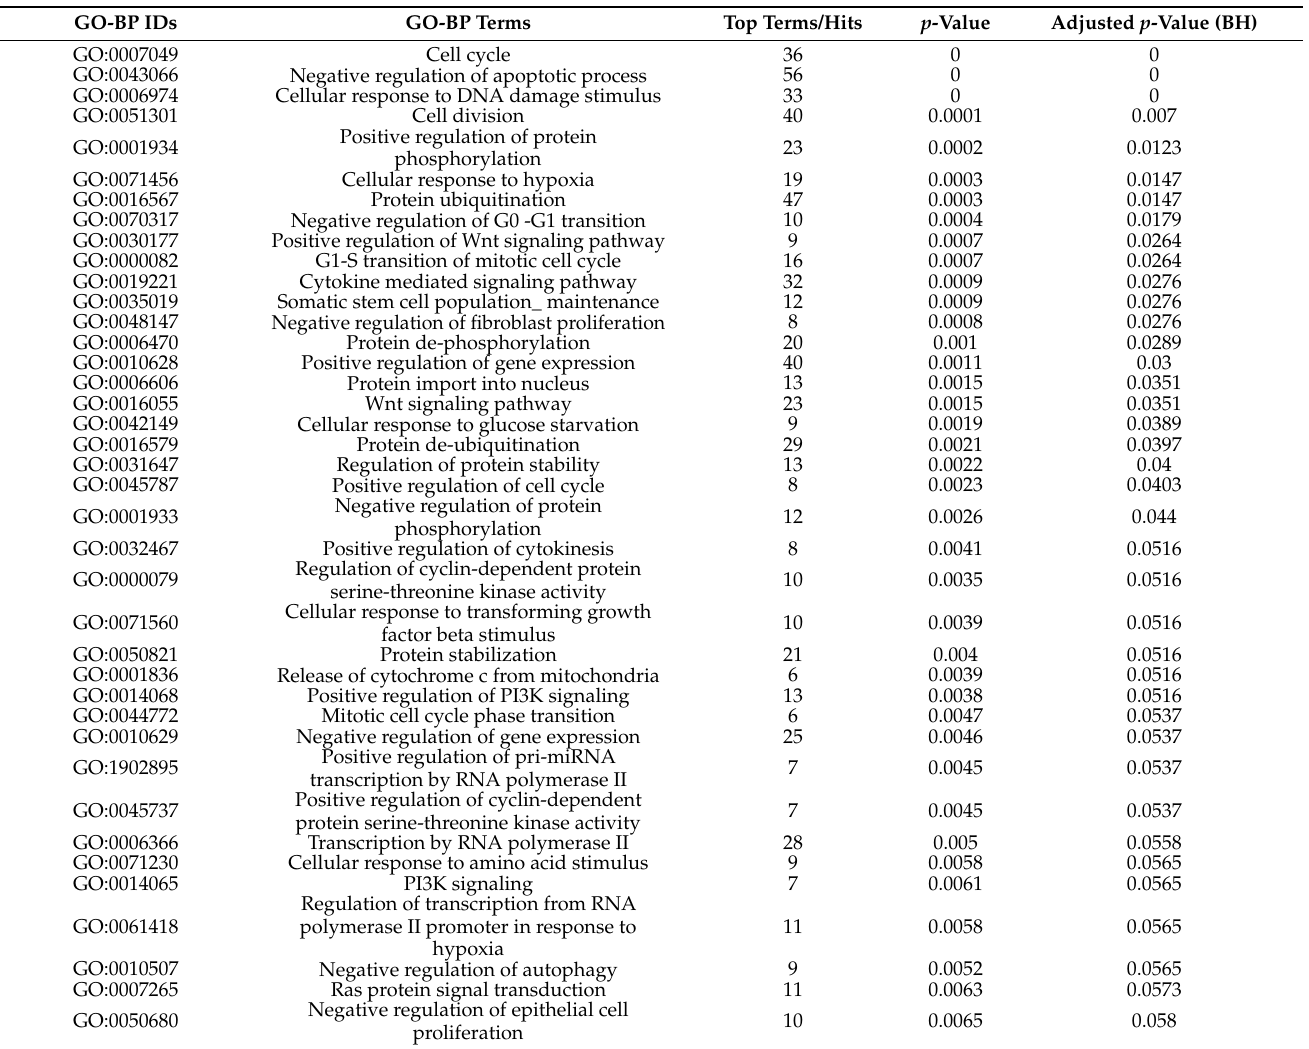
Table 3. The most significant gene ontology terms of predicted miRNA target genes. Significant unique gene ontology terms for biological processes enriched in TNBC corresponding to the significant terms of adjusted p -value (BH) ≤